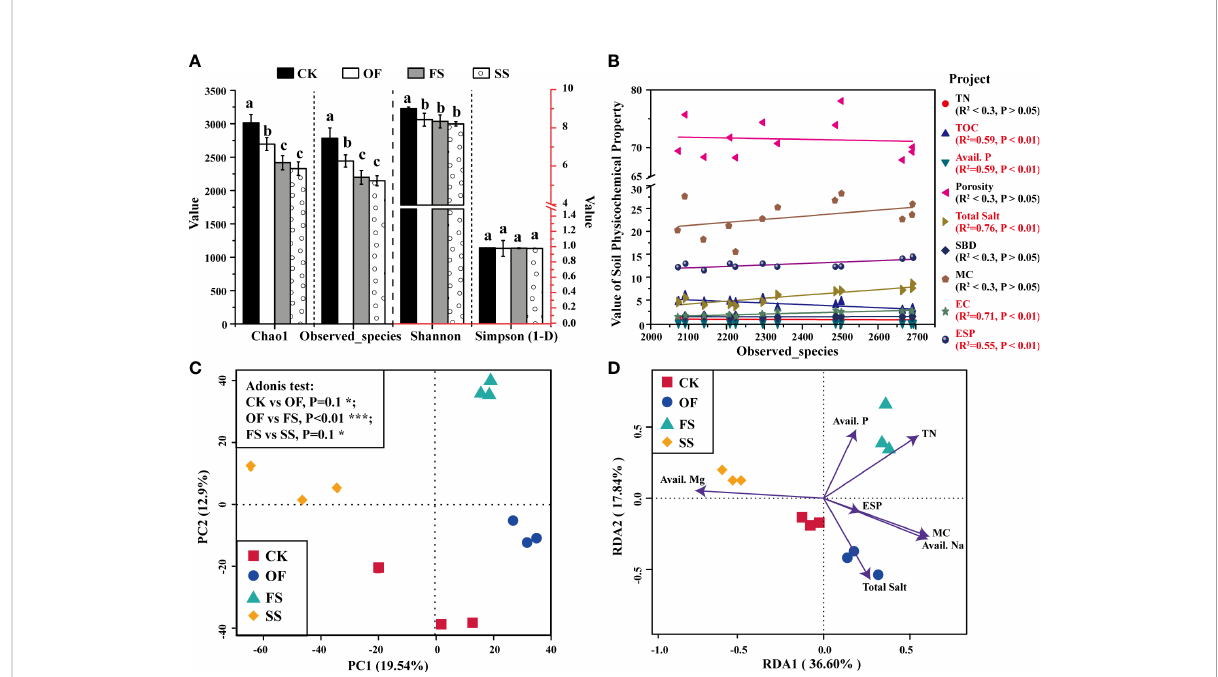
FIGURE 2 (A) Bacterial alpha diversity indices of S. cannabina rhizosphere in CSS with different treatments (the different lowercase letters of the same index in different sample groups indicate that there is a signi fi cant difference between the groups in this index [according to Duncan ’ s signi fi cance test, P< 0.05)]; (B) Linear fi tting relationship between environmental factors and bacterial alpha diversity; (C) Principal component analysis diagram shows the difference of bacterial community among different samples; (D) Redundancy analysis diagram shows the correlation analysis between bacterial communities and environmental factors in different